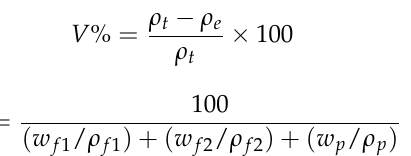
Table 2. Ply orientation and stacking sequence of the composites: PALF (P) and carbon fibre (C). Lamination Orientation Layering Pattern